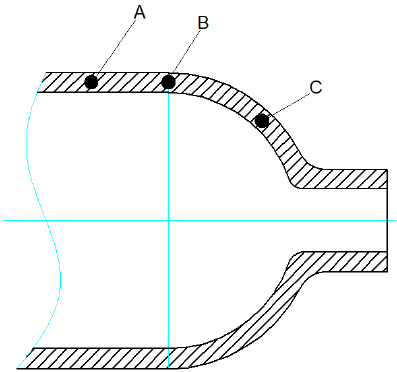
Figure 9. Sampling Figure 9. Sampling locations.